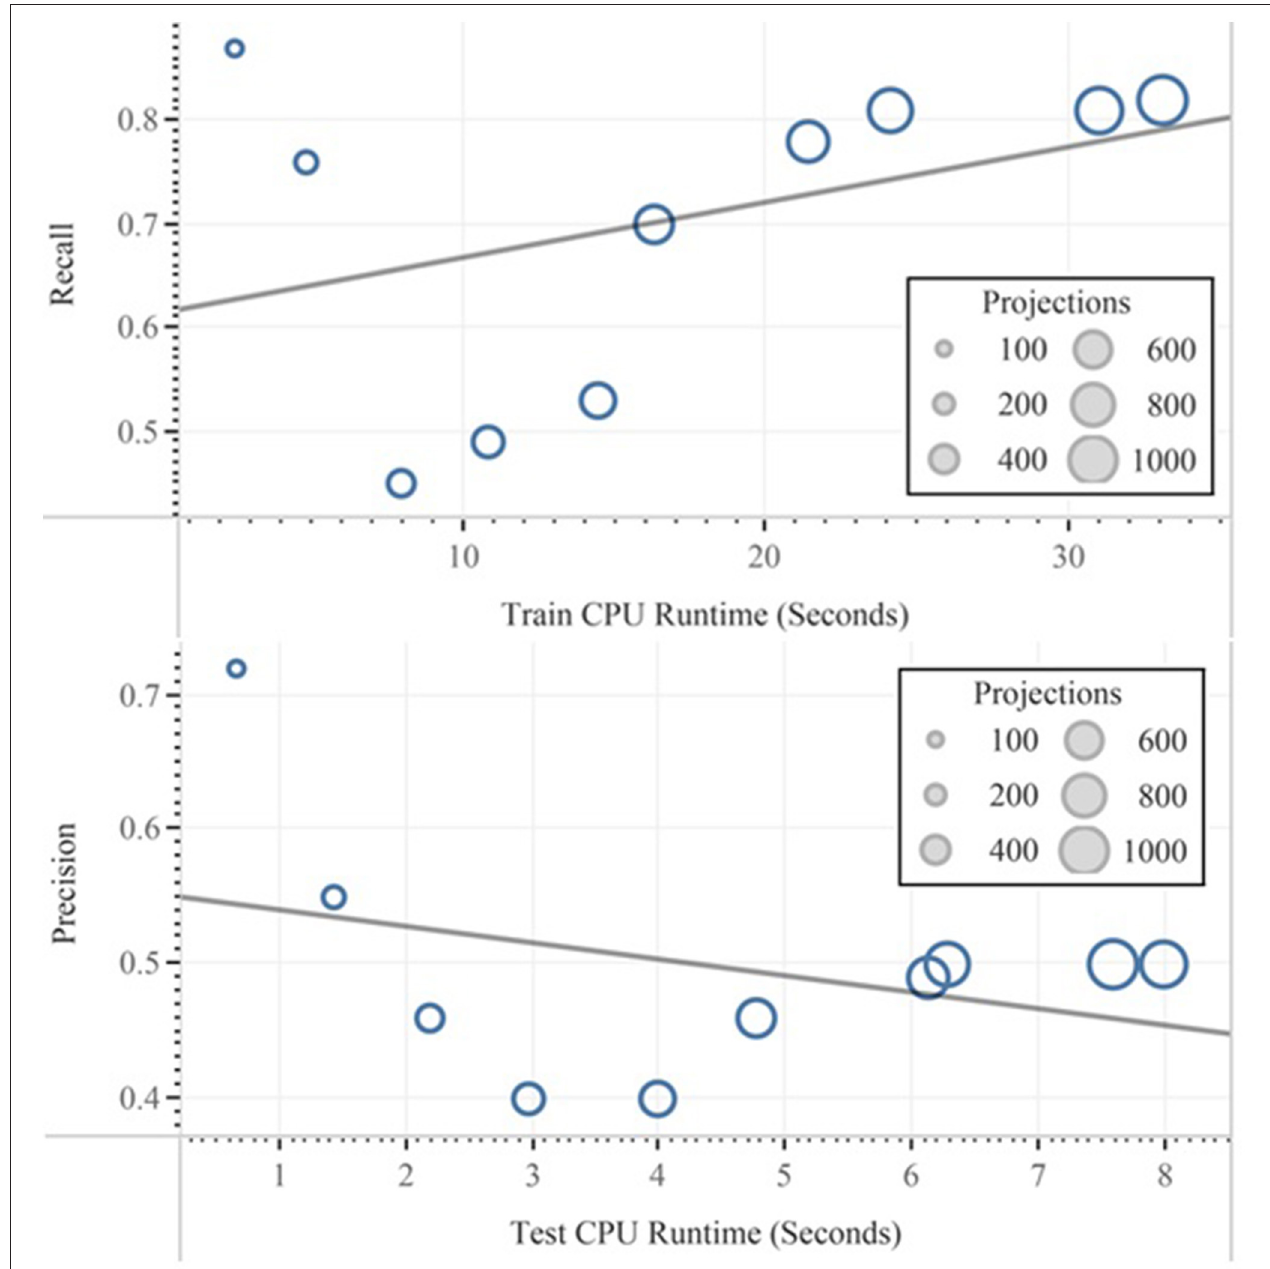
FIGURE 10 | Effect of the projection numbers on precision and runtime implemented with